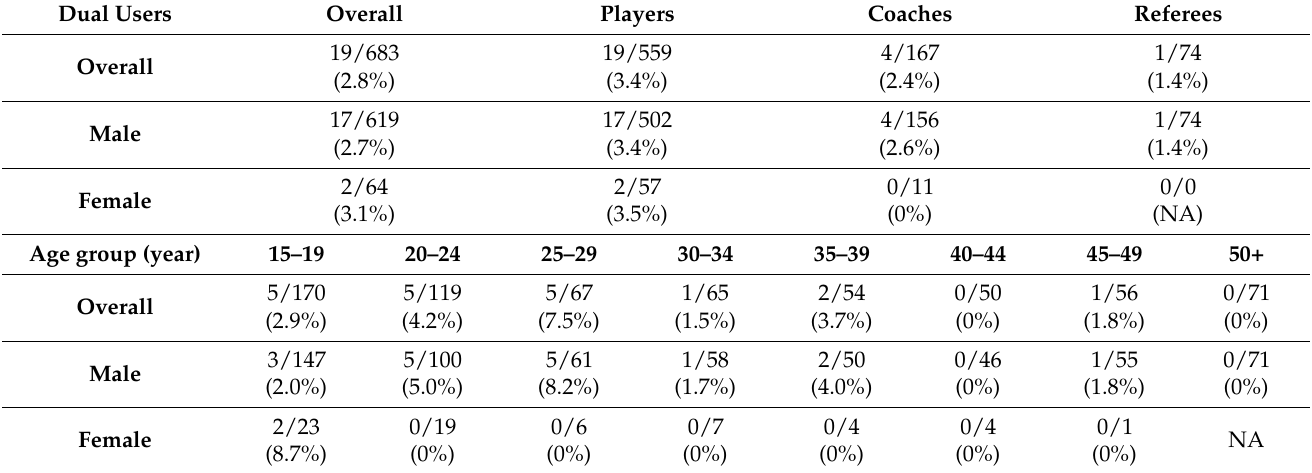
Table 4. Characteristics of dual users in the whole population and according to the type of participant, age group, and gender {n (%)}.Bold and shading: type of participant and age groups. NA = Not